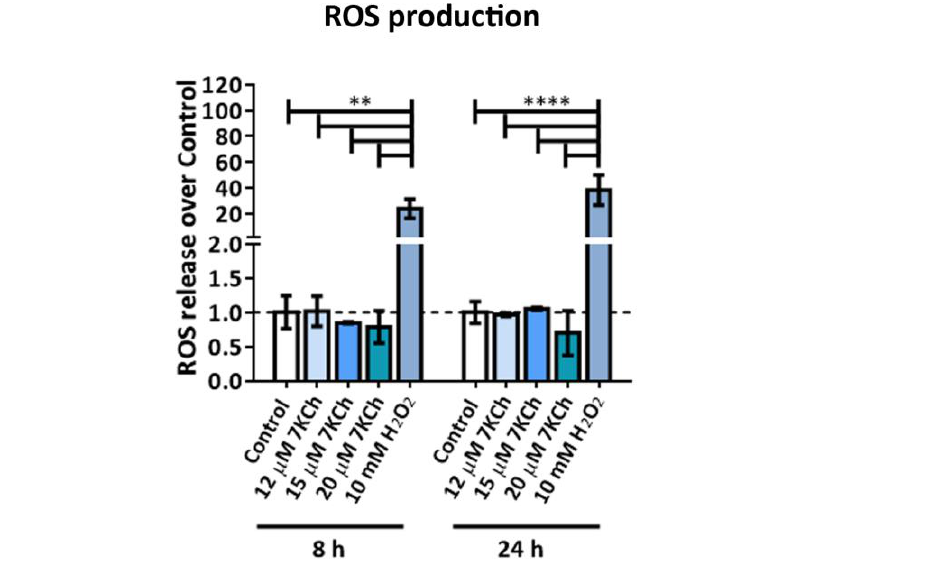
Figure 5. ROS released in mRPE cells exposed to 12–20 µ M 7KCh for 8 h and 24 h. ROS production levels were measured by oxidation of H 2 DCFDA probe to DCF, and 10 mM H 2 O 2 was used as a positive control. Data are represented as mean ± SEM of at least three different experiments. The dashed line is a guidance of the control value. ANOVA test was used for statistical analysis followed by Tukey post hoc test. ** p < 0.01; **** p < 0.0001.